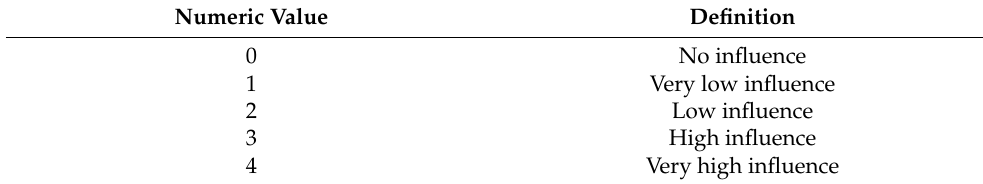
Table 1. DEMATEL comparison scale